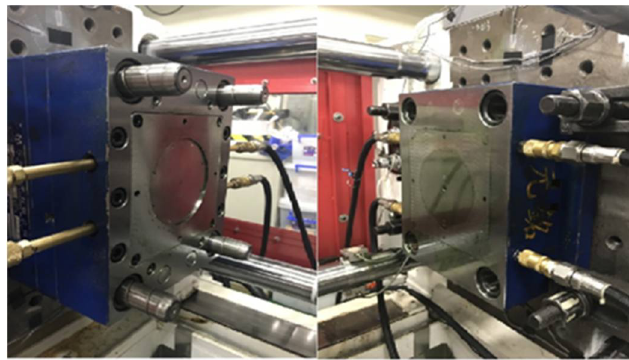
Table 3. A 60-ton injection molding machine (CLF-60TX, Chuan Lih Fa Co., Ltd, Tainan,